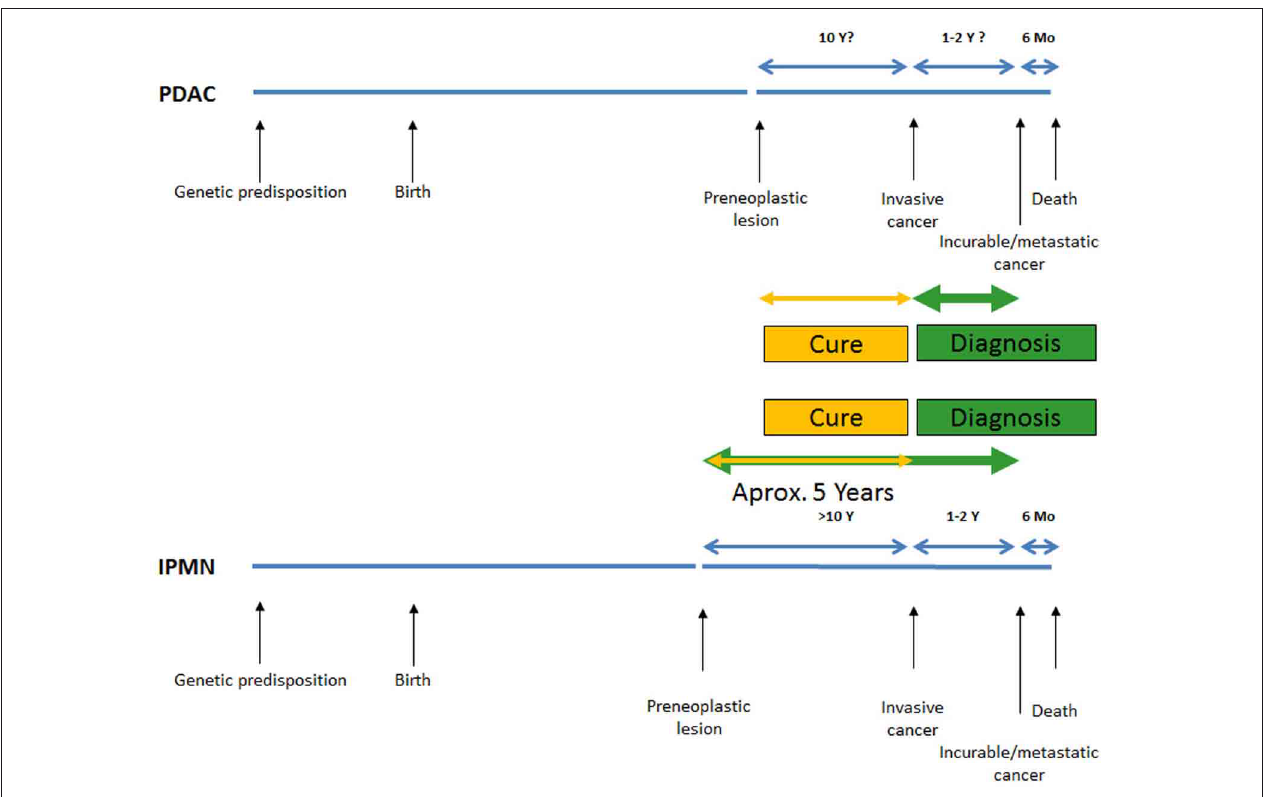
FIGURE 6 | Schematic comparison of the therapeutic time window between pancreatic ductal adenocarcinoma and the intraductal papillary mucinous neoplasia (Yamao et al., 2000; Salvia et al., 2004; Sohn et al., 2004; Yachida et al., 2010; Matthaei et al.,